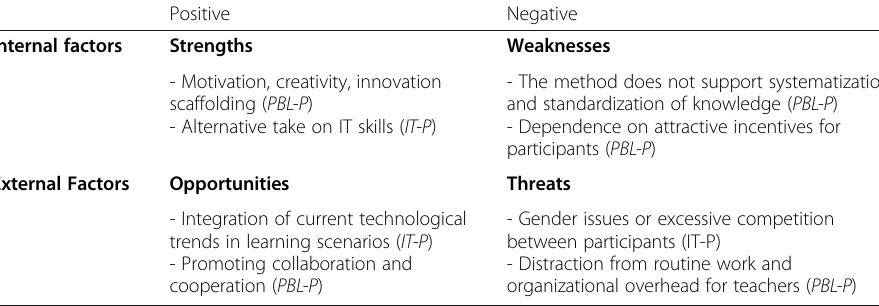
Table 3 SWOT analysis of the proposed